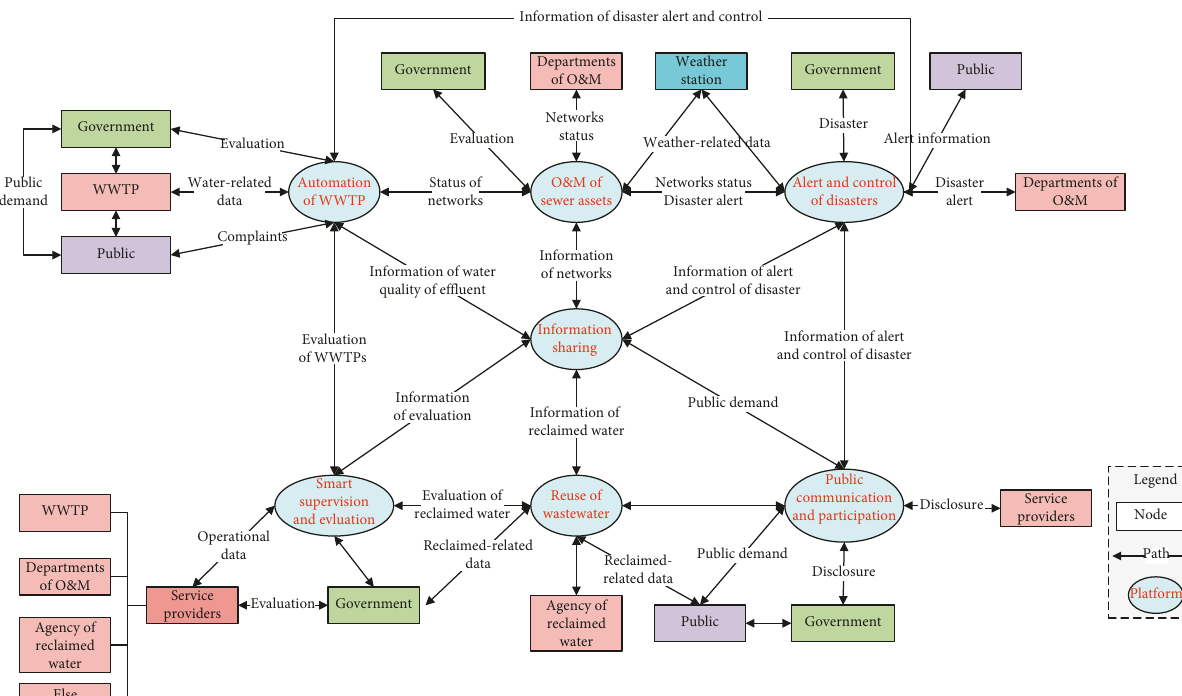
Figure 6: Information chain model of